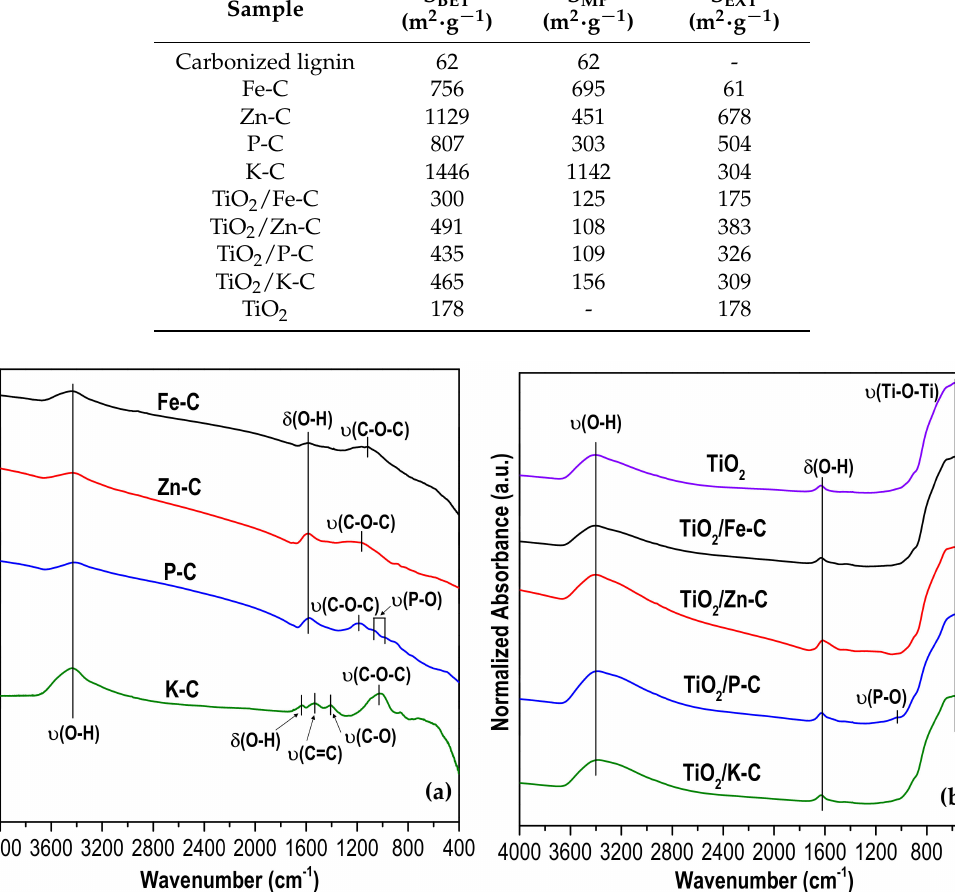
Figure 4. FTIR spectra of: ( a ) activated carbons; ( b ) TiO 2 and TiO 2 /x-C